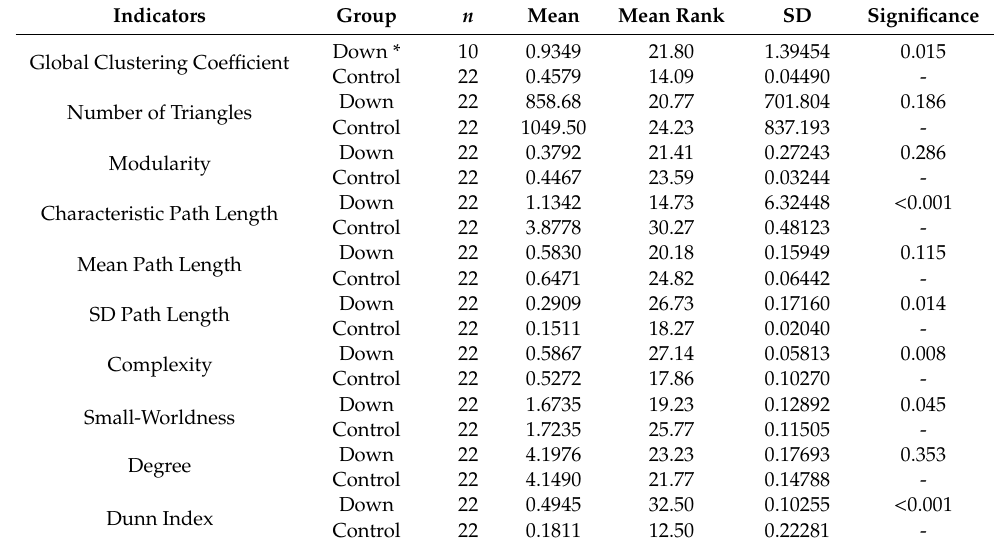
Table 3. Statistical descriptive indexes for DS and control